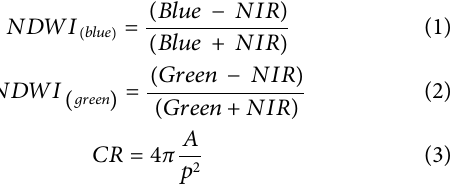
Frontiers in Earth Science |